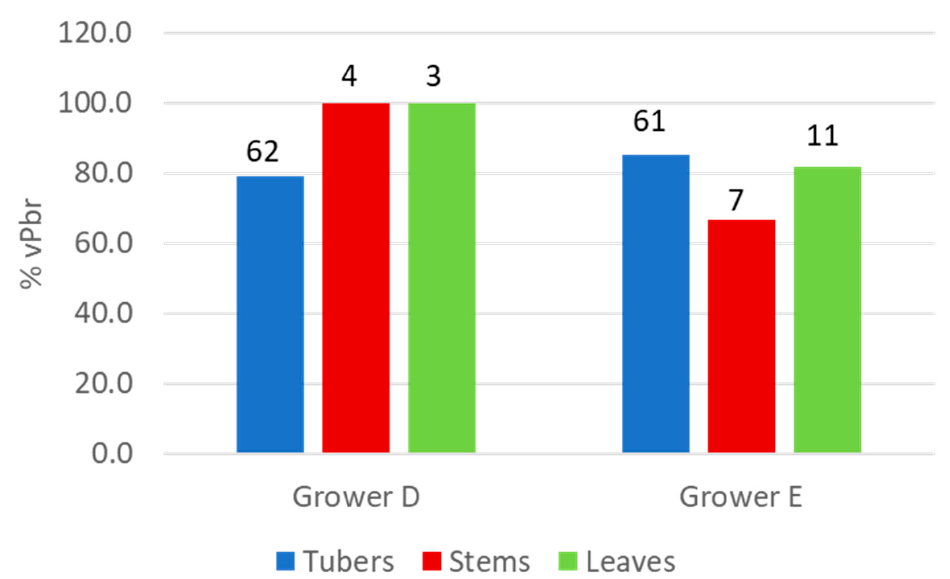
Figure 2. Percentage of samples (tubers, stems, or leaves) of a potato crop grown from minitubers positive in a TaqMan assay for a homogeneous clade of predominantly highly virulent P. brasiliense (vPbr TaqMan) calculated of the total number of positive samples in a Pbr TaqMan assay detecting all P. brasiliense strains. Number of samples positive with the Pbr TaqMan is indicated on top of the bars. The presence of the various clades of P. brasiliense was confirmed by dilution